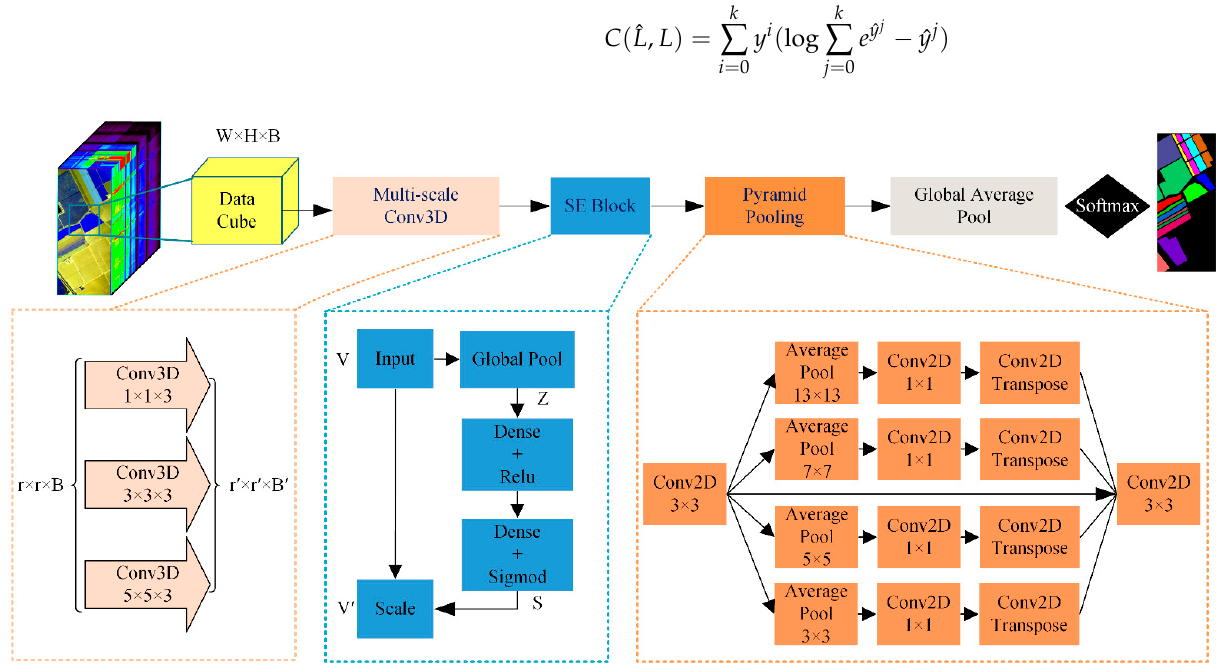
Figure 1. Illustration of the proposed model MSPN.